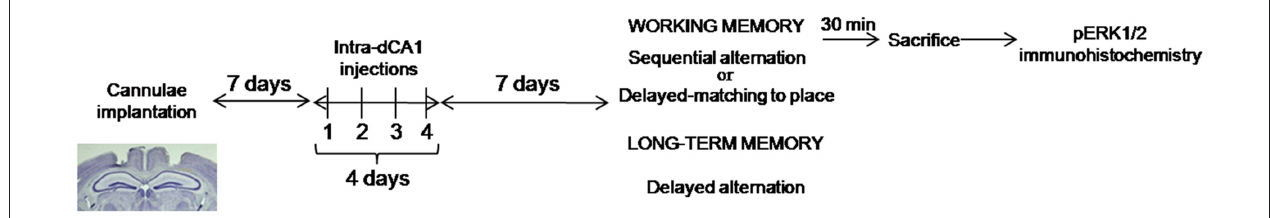
FIGURE 1 | Experimental design of behavioral experiments . Mice received bilateral, intra-dCA1 injections of A β o ( 1–42 ) or Vehicle solution during 4 consecutive days (one injection per day). Seven days after the last injection, separate cohorts of mice belonging to the A β o ( 1–42 ) and Vehicle-infused groups were tested for working or spatial memory function using three different behavioral tasks. Working memory was tested using the sequential alternation task in a T-maze (A β o ( 1–42 ) : n = 10, A β ( 1–42 ) scramble: n = 10 and Vehicle: n = 18) and the delayed matching to place paradigm in the Morris water maze (A β o ( 1–42 ) : n = 8 and Vehicle: n = 9); Spatial memory was evaluated using the delayed alternation task in the T-maze (A β o ( 1–42 ) : n = 13 and Vehicle: n = 7). Cohorts of mice tested in the sequential alternation task were killed 30 min after the beginning of the test session for pERK1/2 immunohistochemistry.